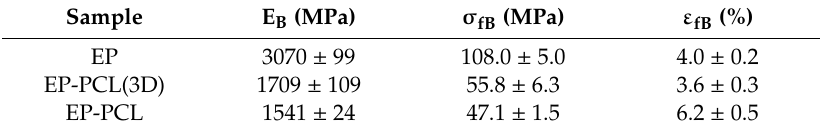
Table 2. Results of quasi-static flexural tests on EP, EP-PCL(3D), and EP-PCL samples